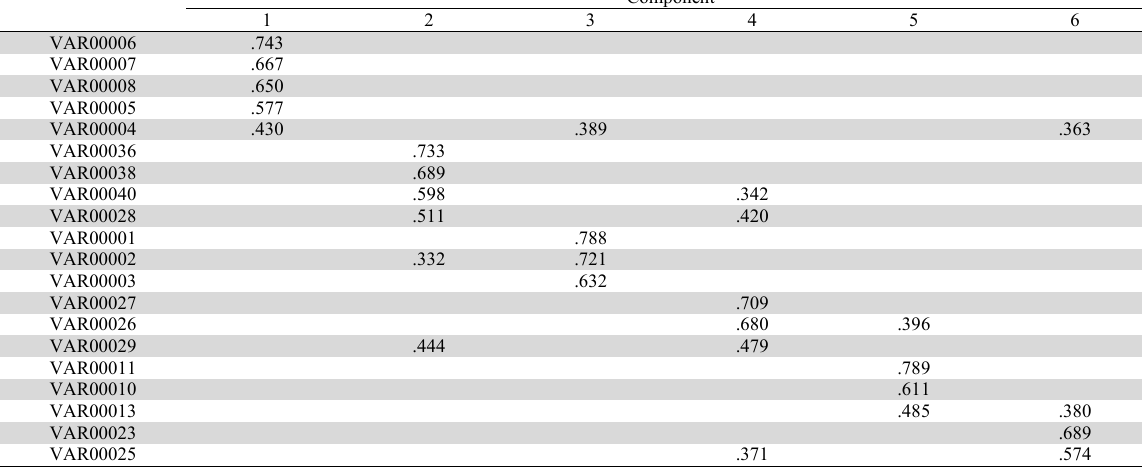
Extraction Method: Principal Component Analysis. Rotation Method: Varimax with Kaiser Normalization. a. Rotation converged in 11